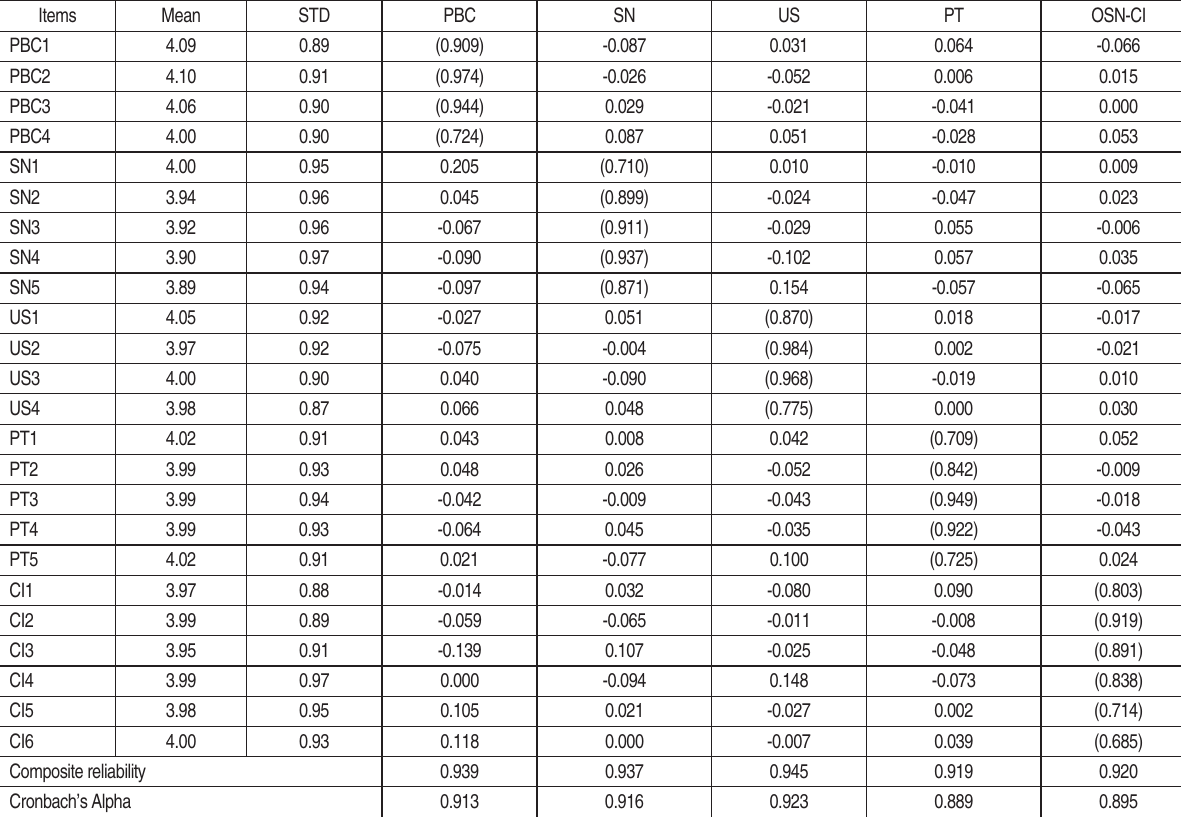
Table 2. Item loadings, cross-loadings and reliability estimations